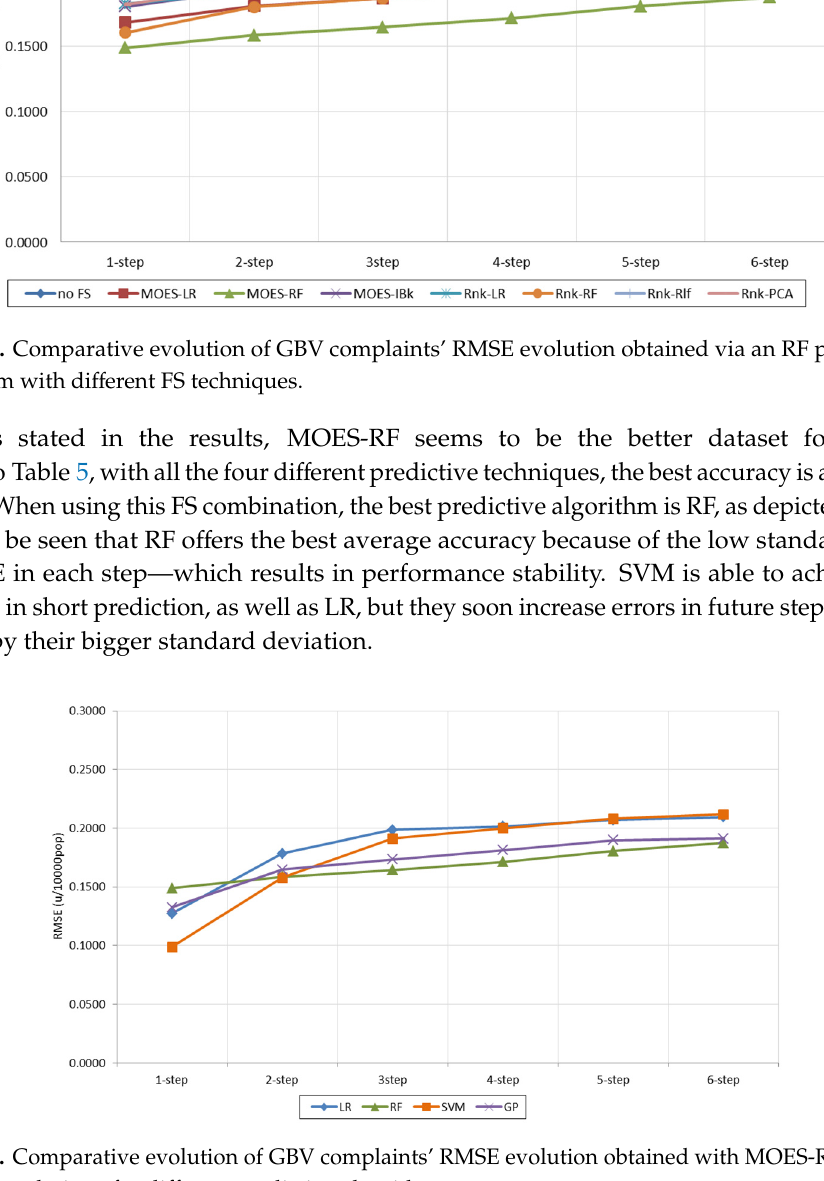
Figure 3. Comparative evolution of GBV complaints’ RMSE evolution obtained with MOES-RF feature selection technique for different predictive algorithms.